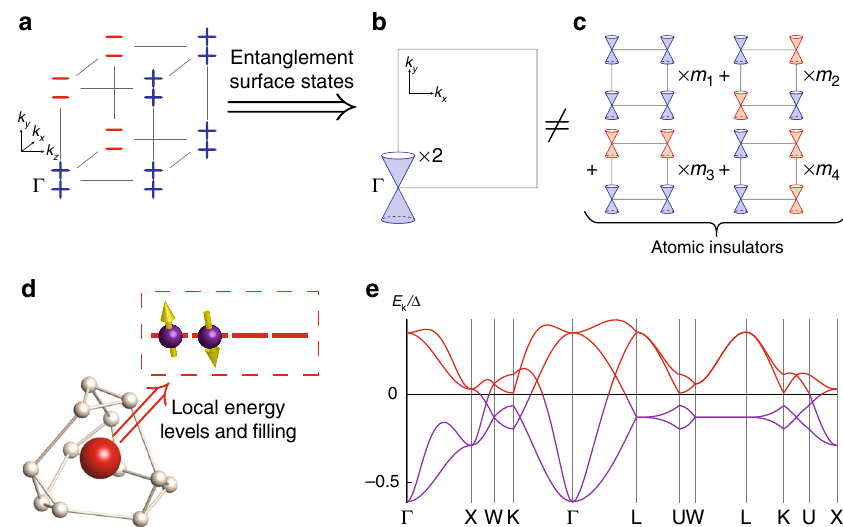
Fig. 2 Examples of topological band structures. a – c A representation-enforced quantum band insulator of spinful electrons with time-reversal and inversion symmetries, dubbed the “ doubled strong TI ” . a Using the Fu-Kane parity criterion 8 , the strong and weak Z 2 indices can be computed from the the parities of the occupied bands, which we indicate by ± at the eight time-reversal invariant momenta. Shown are the parities of one state from each Kramers pair for a doubled strong TI with four fi lled bands . b The entanglement spectrum at a spatial cut, parallel to the x – y plane and containing an inversion center, features two Dirac cones at Γ 13, 14, 16 . Such Dirac cones are known to possess integer-valued charges under the inversion symmetry, and we denote the positively charged and negatively charged cones, respectively, by blue and red . c Inversion-symmetric atomic insulators feature entanglement surface Dirac cones in general, but their presence depends on the arbitrary choice of the cut. We fi nd that the possible Dirac-cone arrangement arising from atomic insulators can only be a linear combination of four basic con fi gurations, illustrated as a sum with the integral weights m i . The arrangement in b cannot be reconciled with those in c , con fi rming the nontriviality of the doubled strong TI. d , e Example of a lattice-enforced semimetal for spinful electrons with time-reversal symmetry. d We consider a site ( red sphere ) under a local environment ( beige ) symmetric under the point group T , and suppose the relevant local energy levels form the four-dimensional irreducible representation, which is half- fi lled ( boxed ). e When the red site sits at the highest-symmetry position of space group 219, the speci fi ed local energy levels and fi lling gives rise to a half- fi lled eight-band model (each band shown is doubly degenerate). Such (semi-)metallic behavior is dictated by the speci fi cation of the microscopic degrees of freedom in this